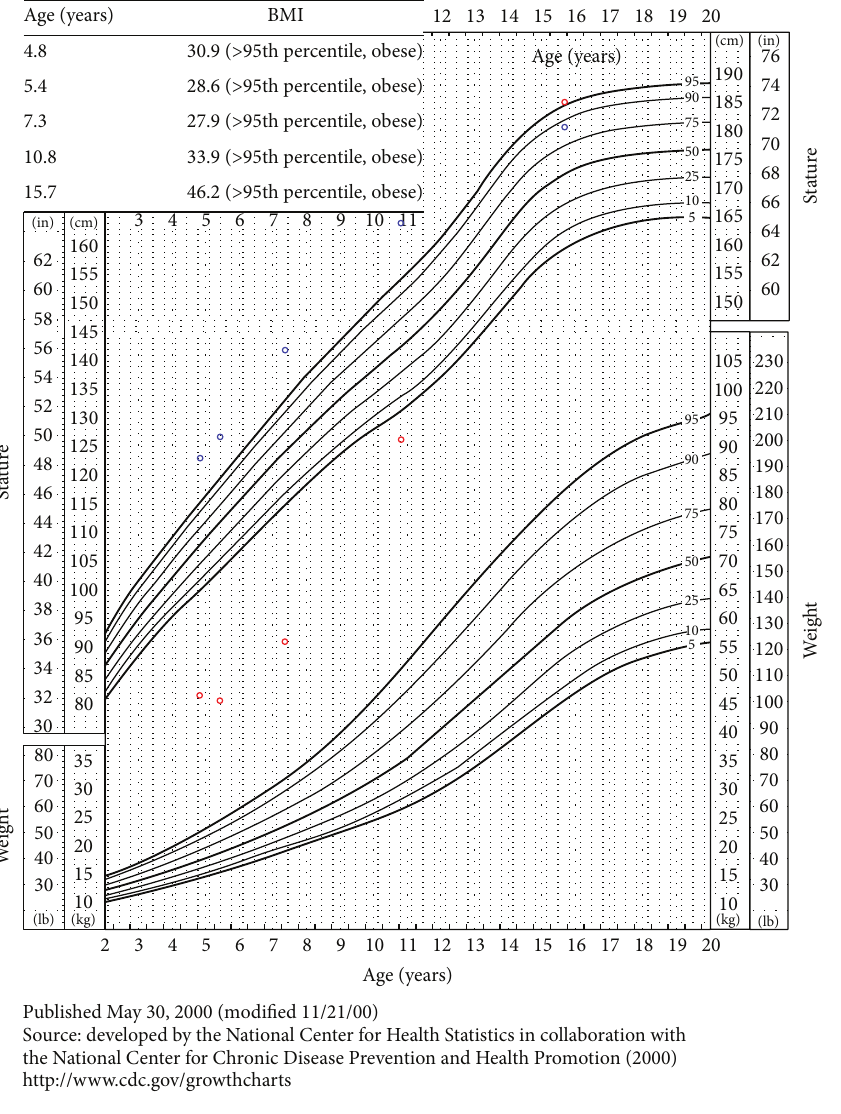
Figure 2: Patient’s BMI, stature-for-age growth chart, and weight-for-age growth chart from 4 years to 16 years. not exhibit the obesity phenotype associated with MC4R mutations. This may be because the other genes present in their deletions may have modified their obesity